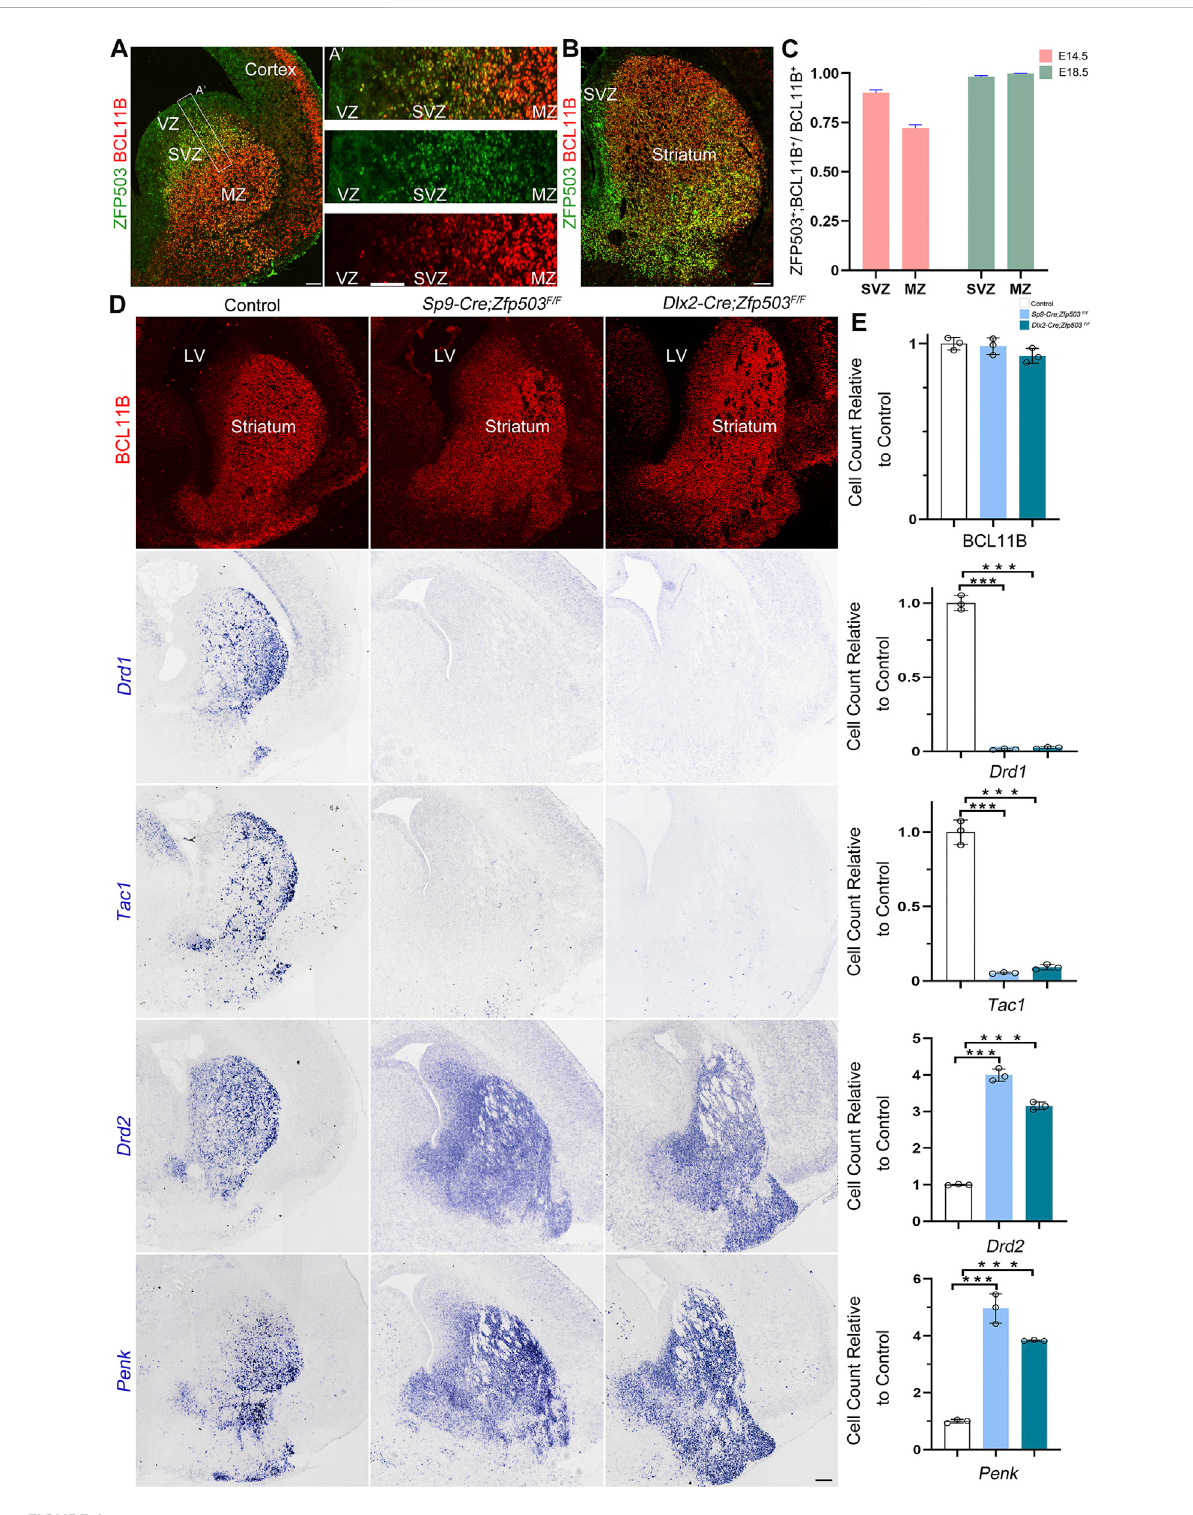
Fate switching of D1 MSNs into D2 MSNs in Zfp503 -CKO mice. (A) ZFP503/BCL11B double-immunostained coronal hemisection at E14.5. (A') High magni fi cation images of the boxed region in (A) . (B) ZFP503/BCL11B double-immunostained coronal hemisection at E18.5. (C) Quanti fi cation showingthatmostoftheZFP503-positivecellsintheLGEwerecolabelledwithBCL11BatE14.5andE18.5. (D) BCL11B-positivecells,whichrepresent the vast majority of striatal MSNs, were similar between Zfp503 -CKO mice and control mice. Drd1 and Tac1 expression was signi fi cantly decreasedwhereas Drd2 and Penk expressionwasmarkedlyincreasedintheLGEatE18.5inthe Zfp503 -CKOmicecomparedtothecontrols. (E) The quanti fi cation data of the (D) . (one-way ANOVA followed by Tukey – Kramer post-hoc test, ***P < 0.001, n = 3, mean ± SEM). Abbreviations: lateral ventricle (LV), mantle zone (MZ), ventricular zone (VZ), subventricular zone (SVZ). Scale bars: 100 µm in A; 100 µm in A ’ ; 200 µm in (D)